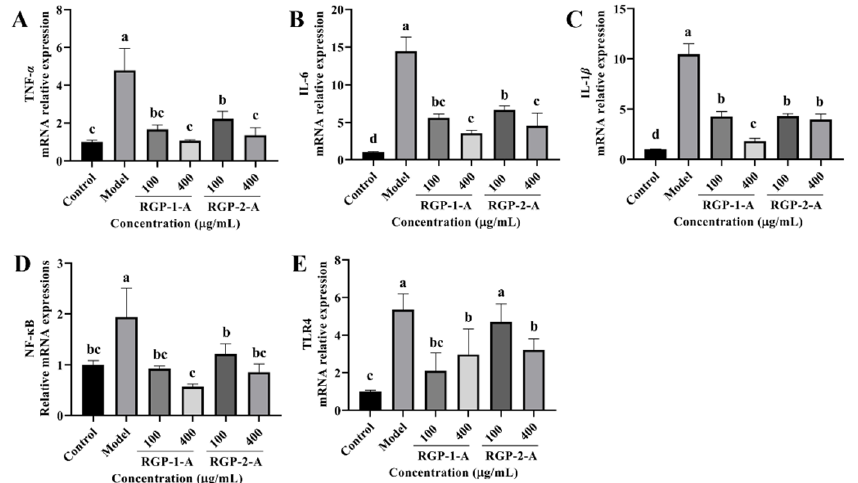
Figure 10. Effect of RGP pretreatment on the relative mRNA expression of inflammatory cytokines and signaling pathway proteins in LPS-induced IPEC-J2 cells. Figure ( A − E ) show the relative mRNA expression levels of TNF- α , IL-6, IL-1 β , NF- κ B, and TLR4, respectively. RGP-1-A: decolorized pure polysaccharides of RGP obtained using AB-8 macroporous resin; RGP-2-A: decolorized pure polysaccharides of RGP obtained using H 2 O 2 . On the bar graphs, different lowercase letters signify a significant difference ( p < 0.05).